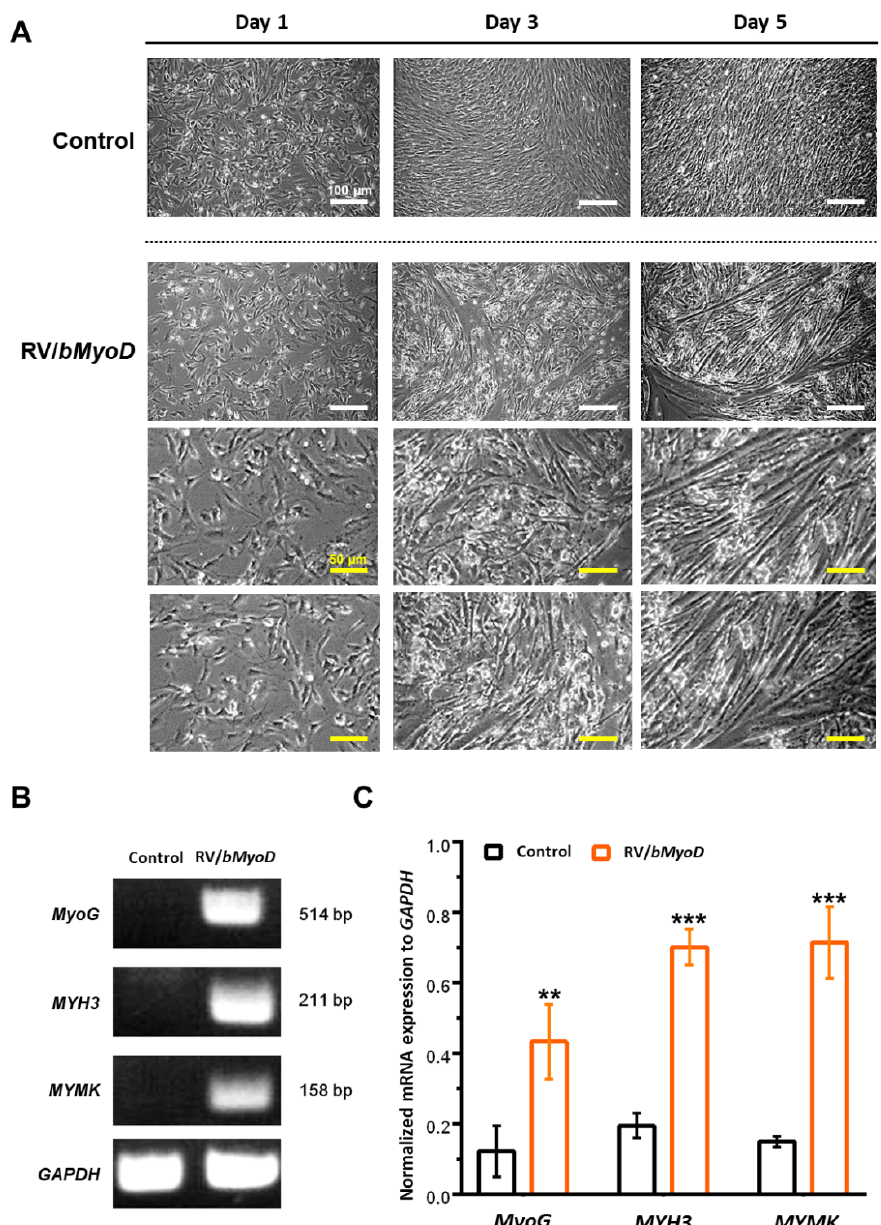
Figure 4. Observation of myotube formation and myogenic gene expression of induced myogenic cells. ( A ) Morphological analysis of BDFs. Induced myogenic cells using RV/ bMyoD showed formation of microtubes. Scale bars, 100 µ m in white and 50 µ m in yellow. ( B ) PCR gel images of representative myogenic genes: MyoG , MYH3 , MYMK . ( C ) Quantification of gene expression using Image J. n = 3 per group. Statistical significance was determined using one-way ANOVA in comparison with the non-treated control BDFs. ** p < 0.01, *** p < 0.001.